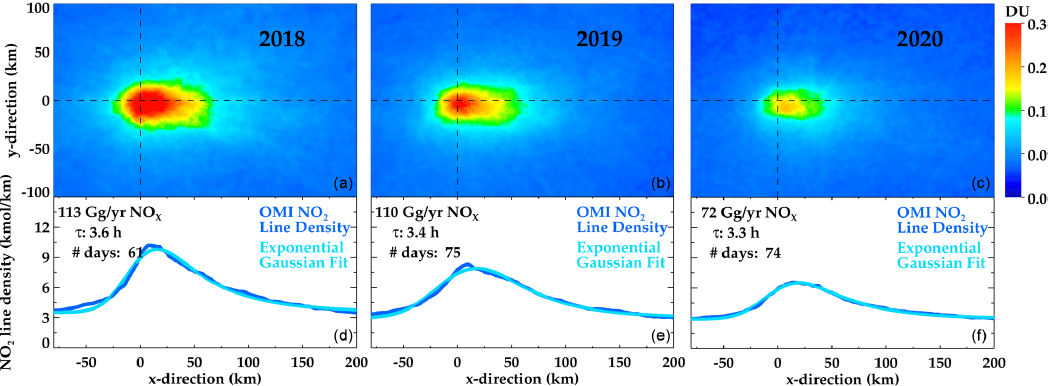
Figure 5. Five-month averaged (May–September) top-down NO x emission estimates for the New York metropolitan area, for 2018 (a, d) , 2019 (b, e) and 2020 (c, f) . TROPOMI NO 2 data is rotated based on daily wind direction. (d) , (e) , and (f) show the TROPOMI NO 2 line densities, which are integrals along the y axis ± 50km about the x axis. The statistical EMG fit to the top-down line densities is shown in light